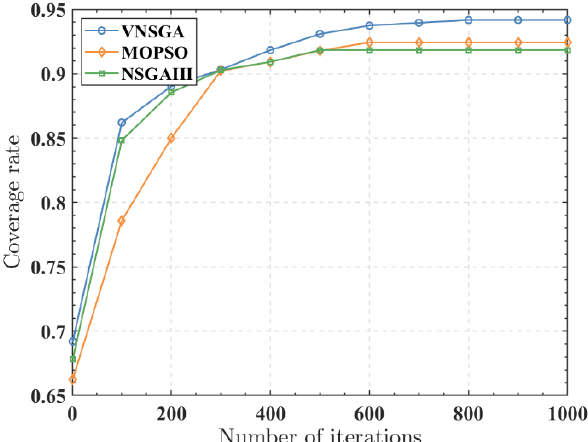
Figure 16. Coverage rate for three algorithms from different iterations for 50 m R s max and 100 m R c max with respect to area A.